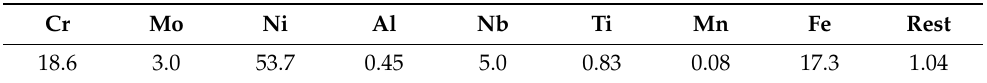
Table 1. Chemical composition in wt % of one of the investigated materials measured using optical emission spectroscopy